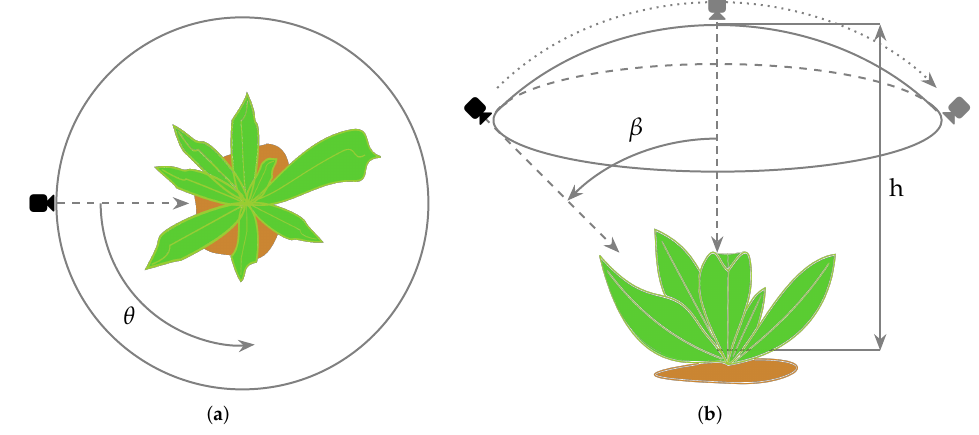
Figure 2. Camera configuration for capturing images. ( a ) top view. ( b ) side